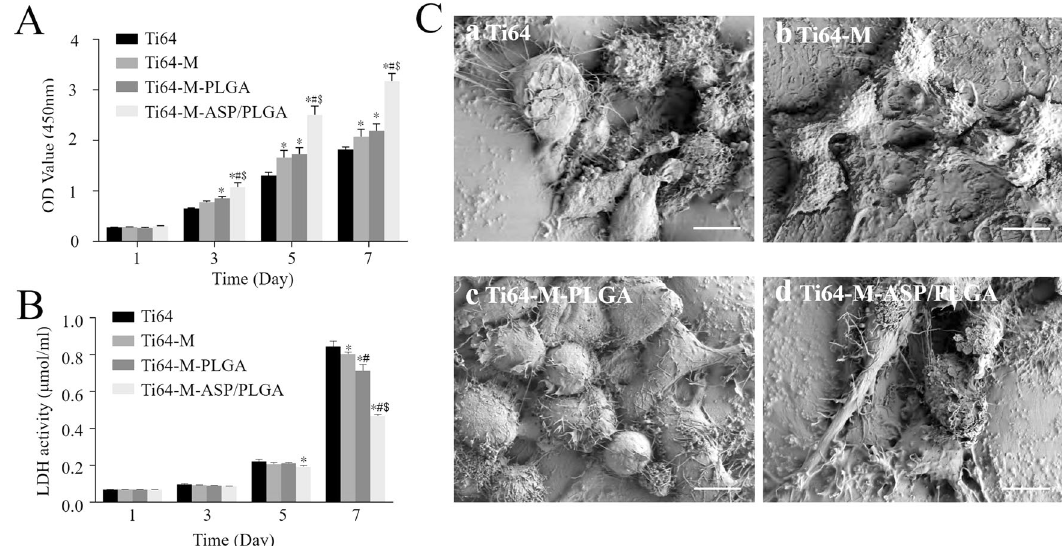
Fig. 3 Effects of different samples on cell proliferation, cytotoxicity and morphology of RAW 264.7 macrophages. A CCK-8 and B LDH activity results of RAW 264.7 cells for 1, 3, 5 and 7 days. C SEM images of RAW 264.7 cells after 24 h of incubation. Data are